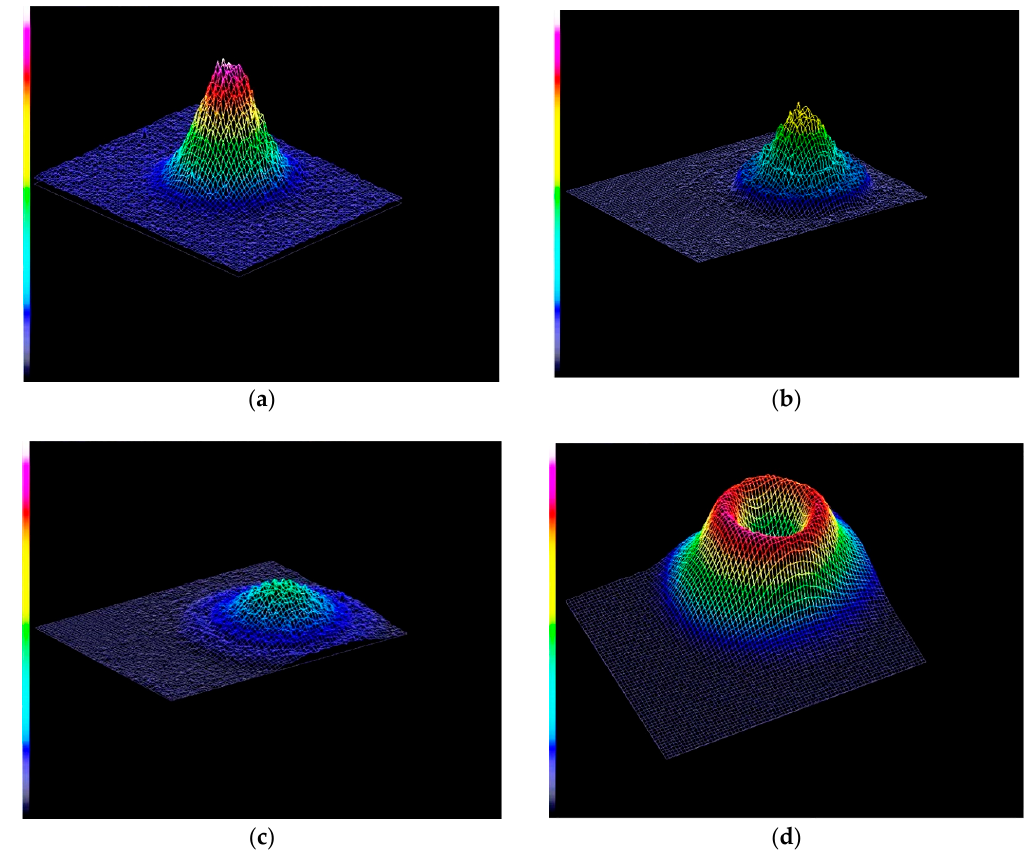
Figure 7. 3D images of the obtained laser beam profiles detected by the CCD camera of the optical monitoring system: ( a ) Gaussian laser beam TEM 00 mode, the effective diameter of the spot D eff = 111 µm; ( b ) small flat top TFT = TEM 00 + TEM 01 * mode, effective diameter of the spot D eff = 260 µm; ( c ) large flat top; ( d ) donut laser beam TEM 01 * mode; the effective diameter of the spot D eff = 347 µm.